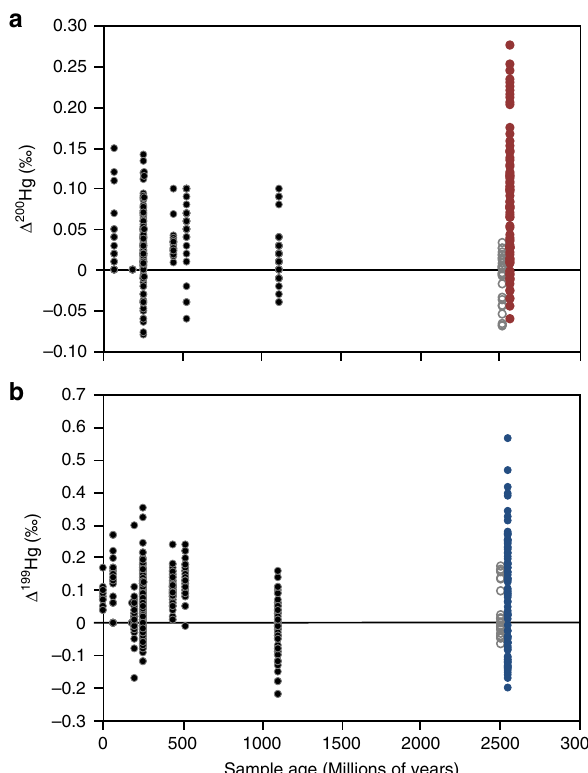
Fig. 3 Temporal plot of mercury isotope data from the rock record. These include Δ 200 Hg (in ‰ , a ) and Δ 199 Hg (in ‰ , b ). Our data are shown as red dots (for Δ 200 Hg) and blue dots (for Δ 199 Hg). Previously published Proterozoic and Phanerozoic data (shown as black dots) are compiled from 15 – 18,20,23,36,38,41,55 – 57 . The only previously published Hg-MIF data from Archean sediments (shown as gray open circles) were from the Mt McRae shale 20 , which have been controversially associated with transient atmospheric oxygen before the GOE 5 .